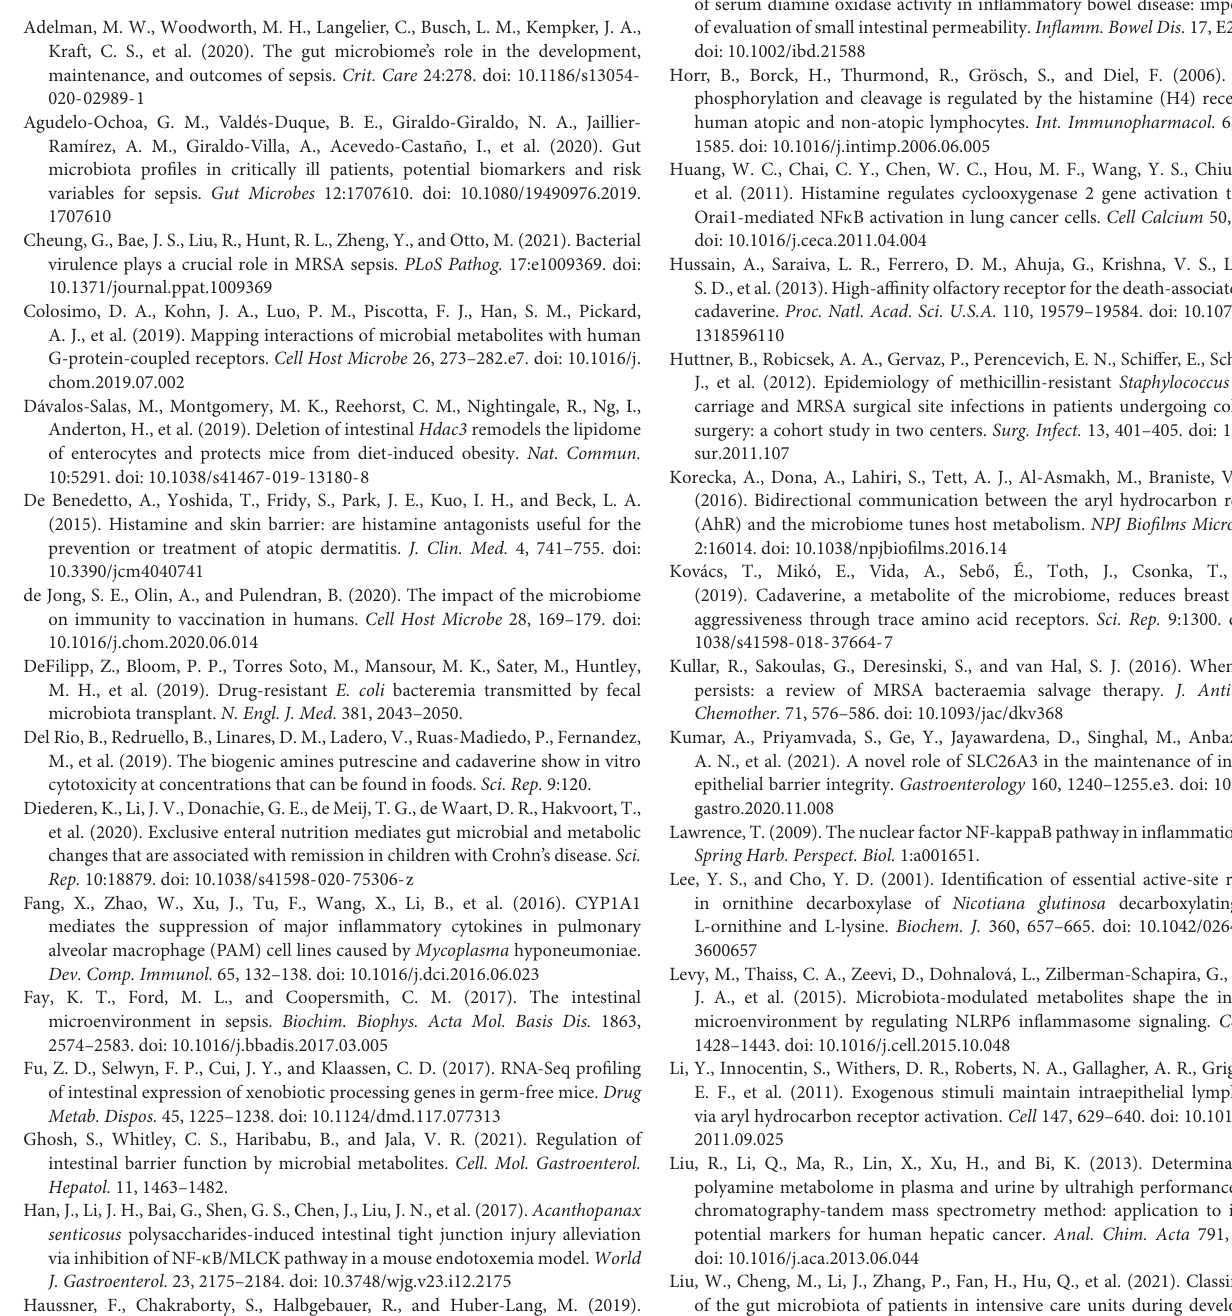
Supplementary Table 2 | Features profiling between Cyp1a1 + / + and Cyp1a1 − / − mice in the presence or absence of MRSA challenge at 24 h. Supplementary Table 3 | The abundance-unweighted Unifrac distance matrix between Cyp1a1 + / + and Cyp1a1 − / − mice in the presence or absence of MRSA challenge at 24